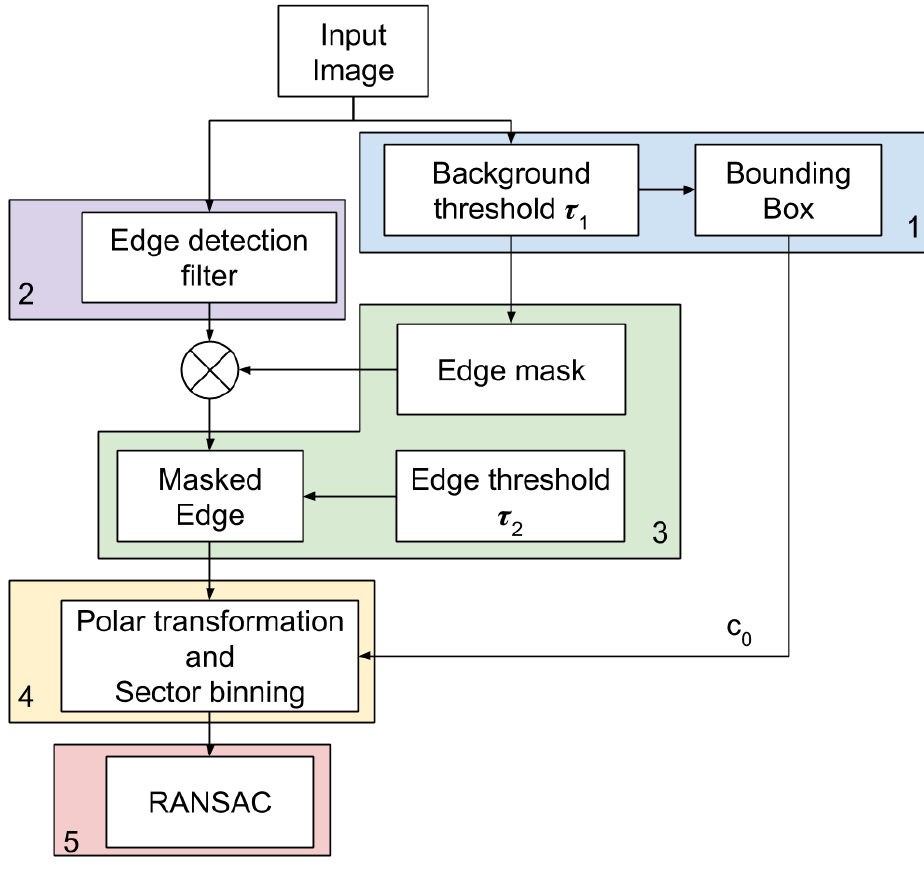
Figure 3. Procedure flowchart. The input image is processed by an edge detector filter and a simple background threshold with threshold parameter τ 1 . The binary output image obtained from the